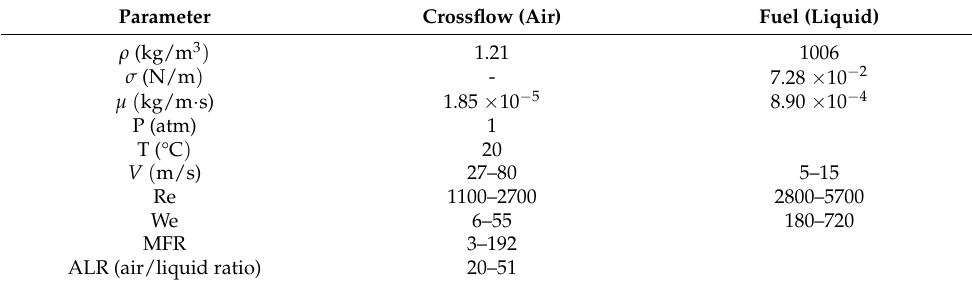
Table 1. Test parameter